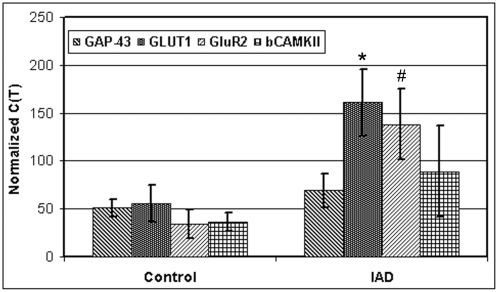
Quantitative RT-PCR confirms upregulation of GLUT1 and GluR2.Total RNA (2 µg) was used to generate cDNA by reverse transcription using oligo-dT primers. Note increased mRNA levels of glutamate transporter (GLUT1) and GluR2 in IAD patients compared to controls. Data are mean values ±SEM comparing 4 control and 4 IAD patients. βCAMKII and GAP43 do not show significant change in mRNA levels. GAP-3 (p<0.1), GLUT1 (* p<0.01), GluR2 (# p<0.03), βCAMKII (p<0.06).